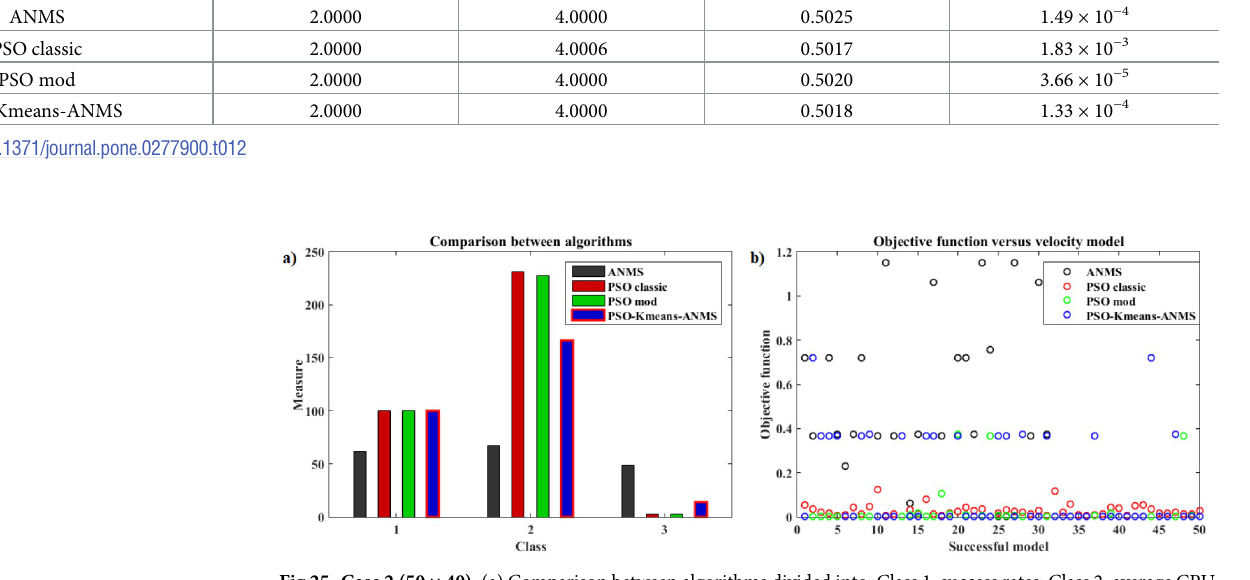
Fig 25. Case 2 (50 × 40). (a) Comparison between algorithms divided into: Class 1, success rates; Class 2, average CPU times and Class 3, average objective function values ( ϕ ( m ) × 10 2 ). (b) Objective function values for successful models.